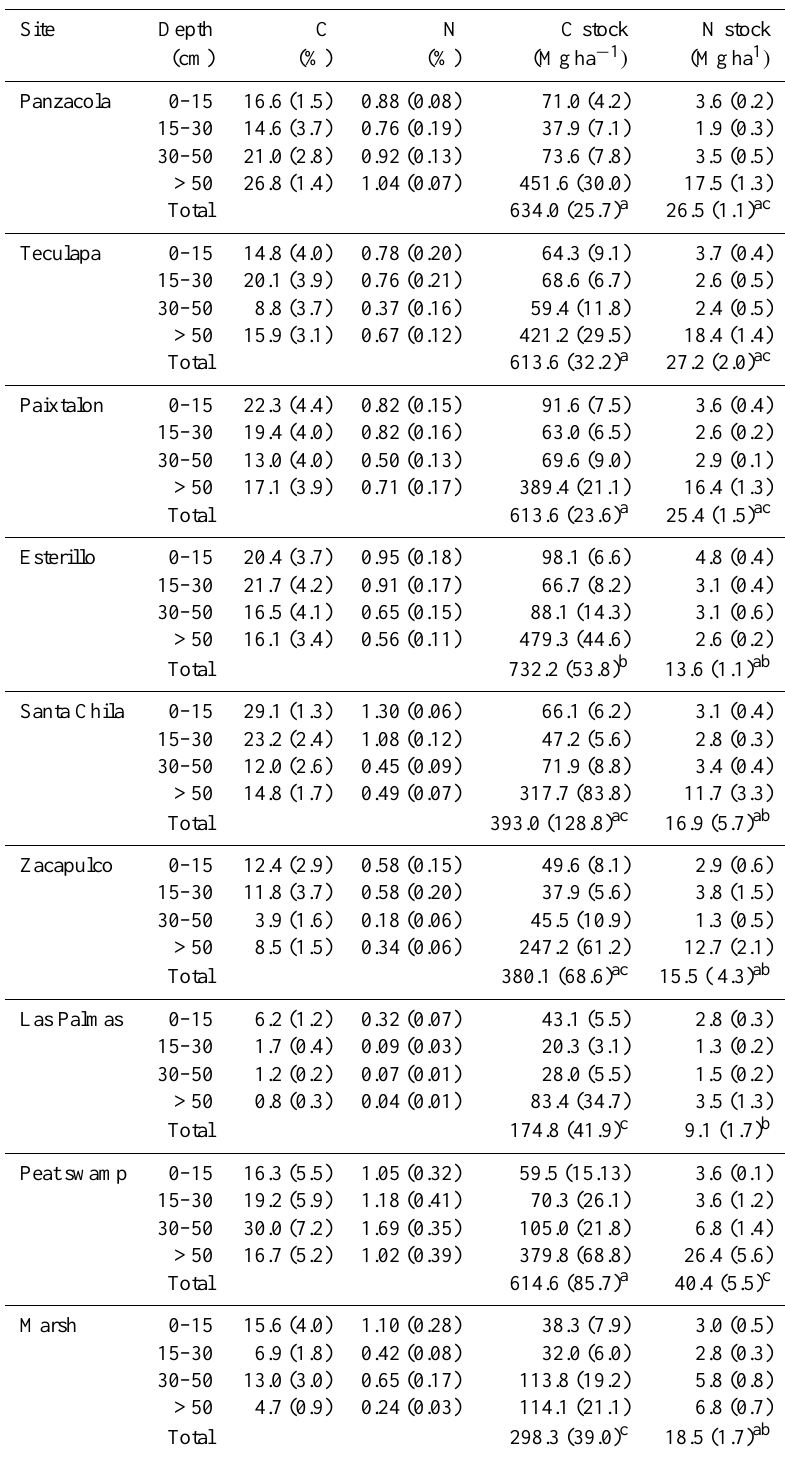
Table 5. Soil carbon (C) and nitrogen (N) concentrations (%), and soil C and N stock (Mgha − 1 ) at different depths (0–150cm) of wetlands from La Encrucijada Biosphere Reserve. Values are shown as mean (standard error). Different letters indicate significant differences between sites ( p